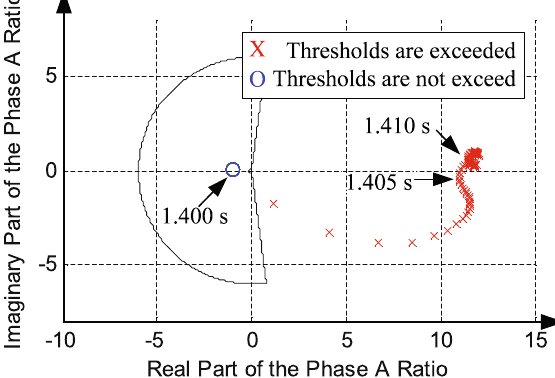
Fig. 6 Calculated current phasor ratio trace of event 1: internal bolted fault, grid-connected